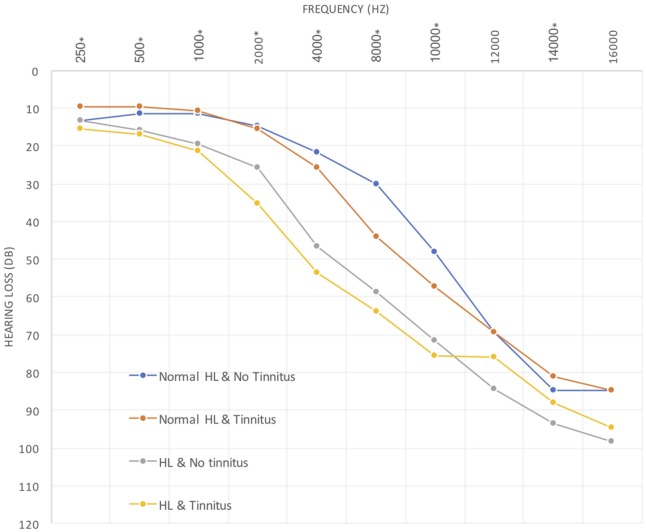
Hearing thresholds between subgroups.